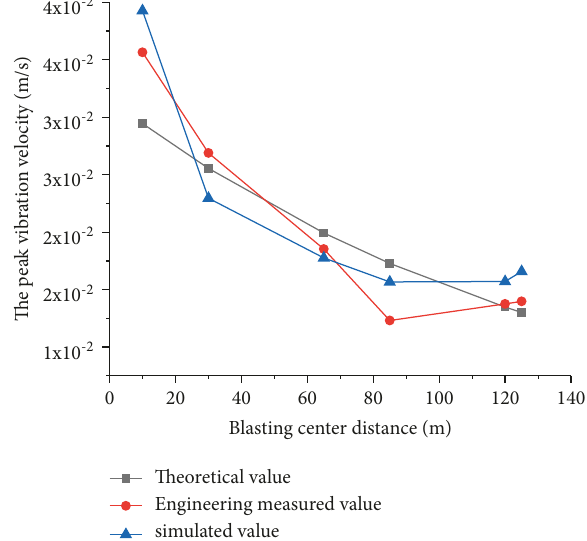
Figure 12: Theoretical-measured-simulated value error analysis.